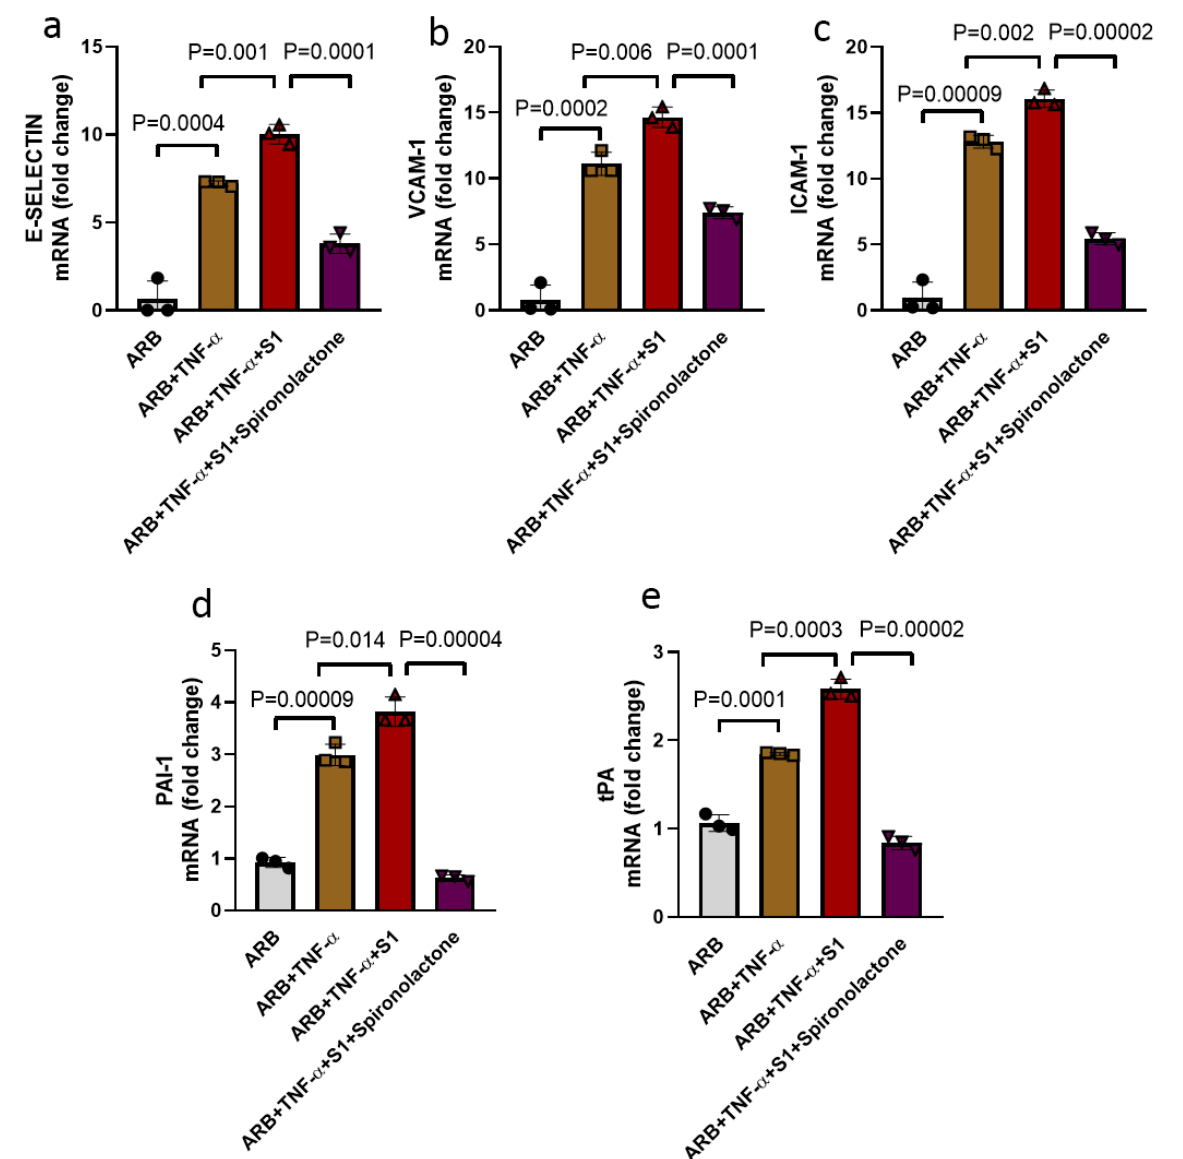
Figure 5. Co-treatment of ECs with S1 and TNF- α enhanced transcript expression of cell adhesion and anti-fibrinolytic/fibrinolytic genes, while spironolactone treatment blocked these effects. ( a ) Transcript expression of cell adhesion molecule E-selectin was increased by TNF- α alone (5 ng/mL) as compared to its control ARB (angiotensin receptor blocker, valsartan) and expression of E-selectin was further enhanced by S1 (25 nM) in the presence of TNF- α . ( b , c ) VCAM-1 and ICAM-1 transcript expression were also significantly enhanced by co-treatment of spike protein + TNF- α , as compared to TNF- α . ( d , e ) Transcript expression of anti-fibrinolytic and fibrinolytic genes PAI-1 and tPA, respectively, were upregulated by TNF- α , and their expression were further increased by S1 in the presence of TNF- α . Spironolactone (10 mM) markedly reduced both cell adhesion (E-selectin, VCAM-1 and ICAM-1) and anti-fibrinolytic and fibrinolytic PAI-1/tPA genes, respectively, in ECs in vitro, n = 3 in all groups. (ARB), (ARB+TNF- α ), (ARB+TNF- α +S1), (ARB+TNF- α +S1+Spironolactone). Data were analyzed by the analysis of variance (ANOVA). p < 0.05 was defined to be statistically significant. All data are expressed as mean ± s.d.